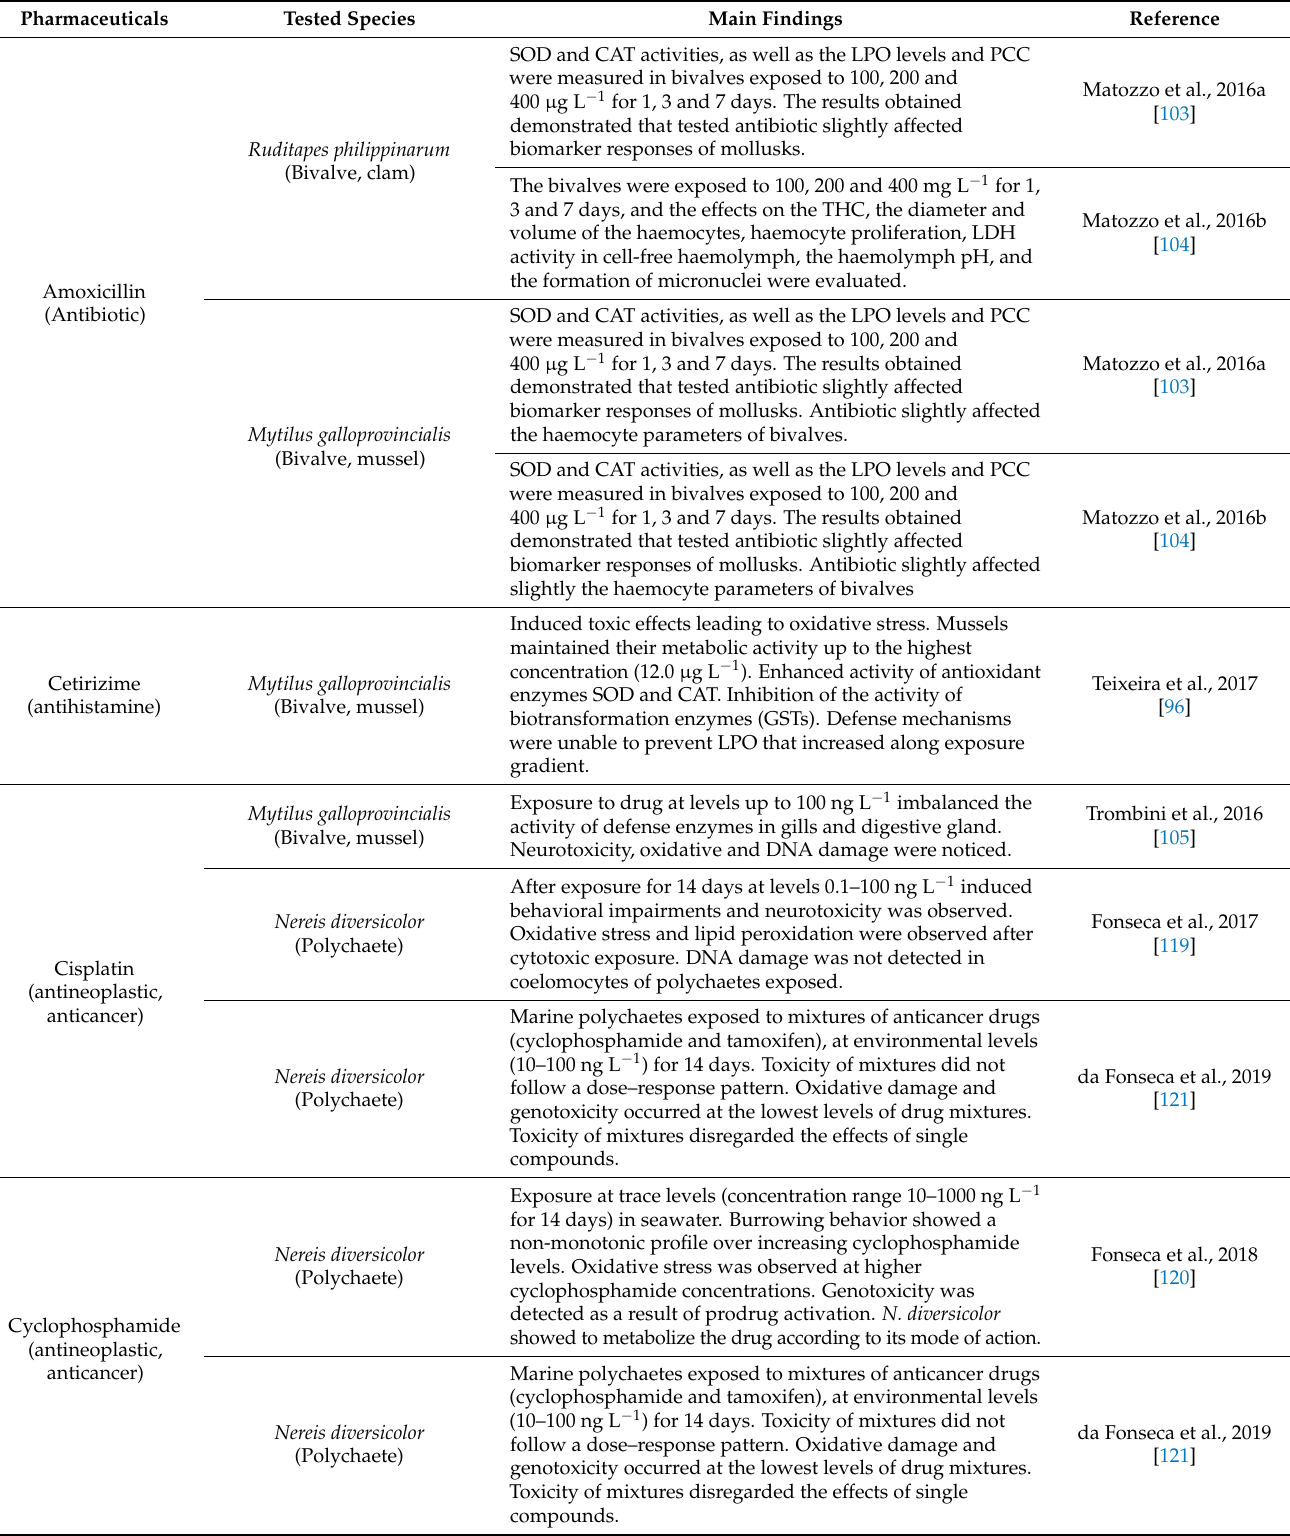
Table 2. Selected studies evaluating the toxicity of pharmaceuticals on marine plant and animal species.